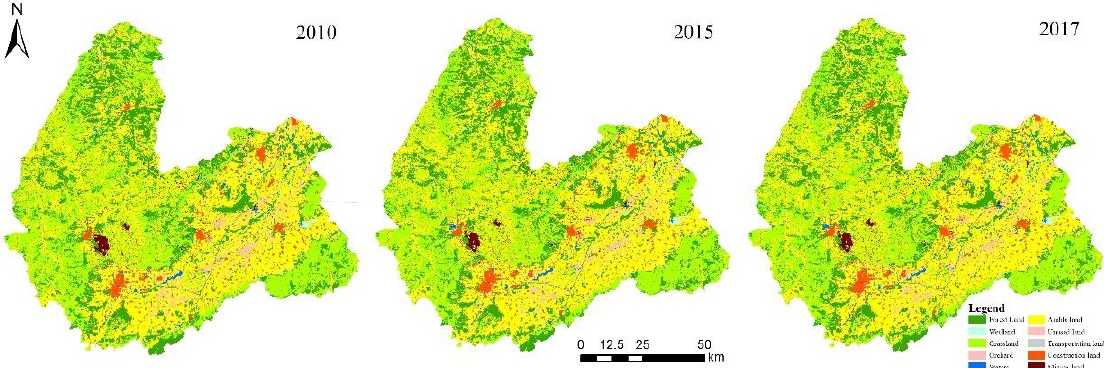
Figure 3. Land-use type distribution from 2010 to 2017.